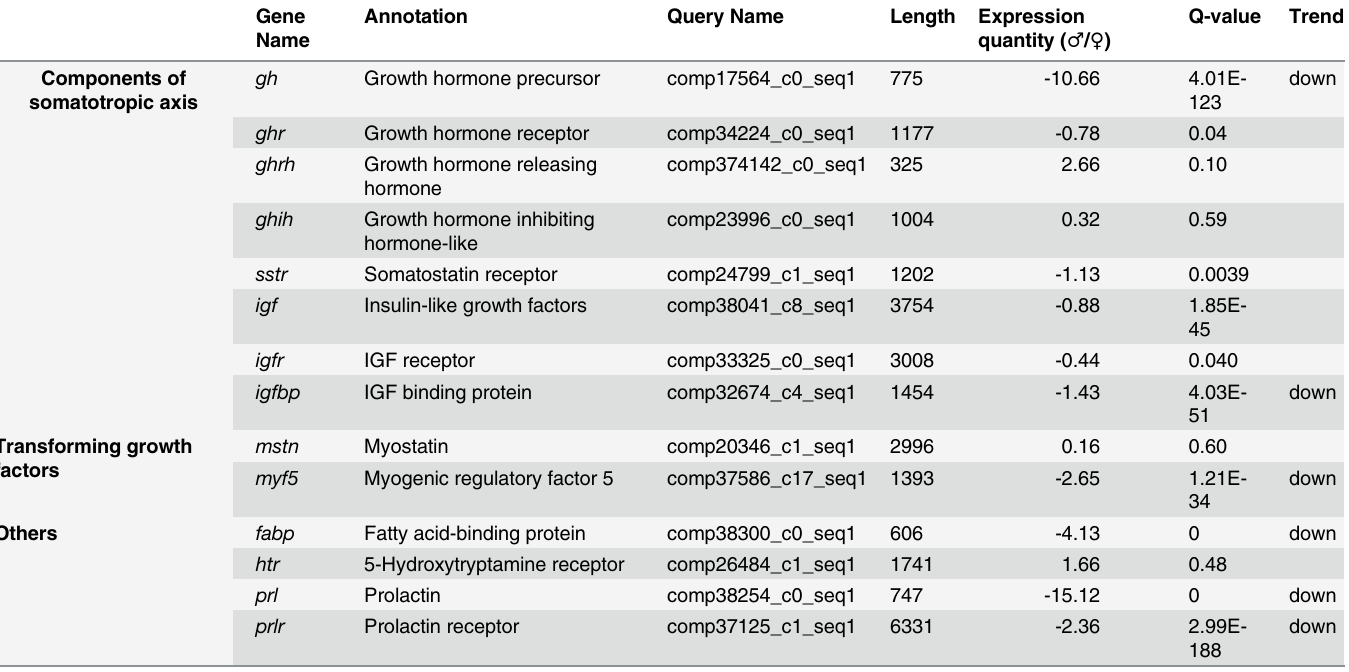
Table 3. Genes of interest for growth and muscle development in Scophthalmus maximus